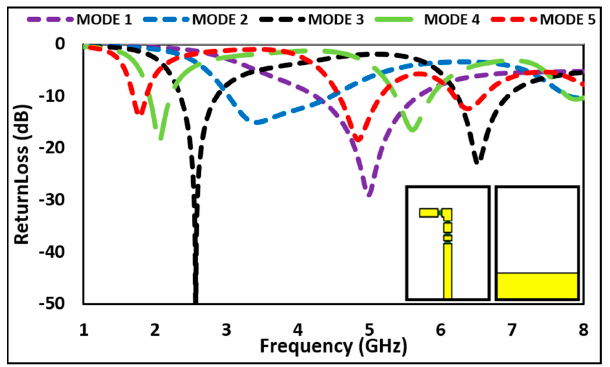
Figure 5. Return loss for all operating modes. The simulated and measured return loss of each mode is compared in Figure 6. The comparison shows a good agreement between measured and simulated results. The Voltage Standing Waves Ratio (VSWR) of less than 1.5 is observed for all resonant bands, which indicates optimum driving-point impedance matching of the antenna. The VSWR is less than 2 for all the operating frequency bands, as depicted in Figure 7.